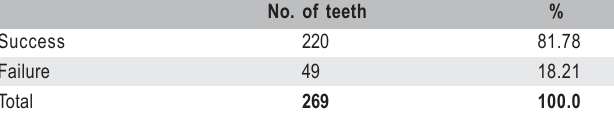
Table 4. Re-evaluation 6 months after